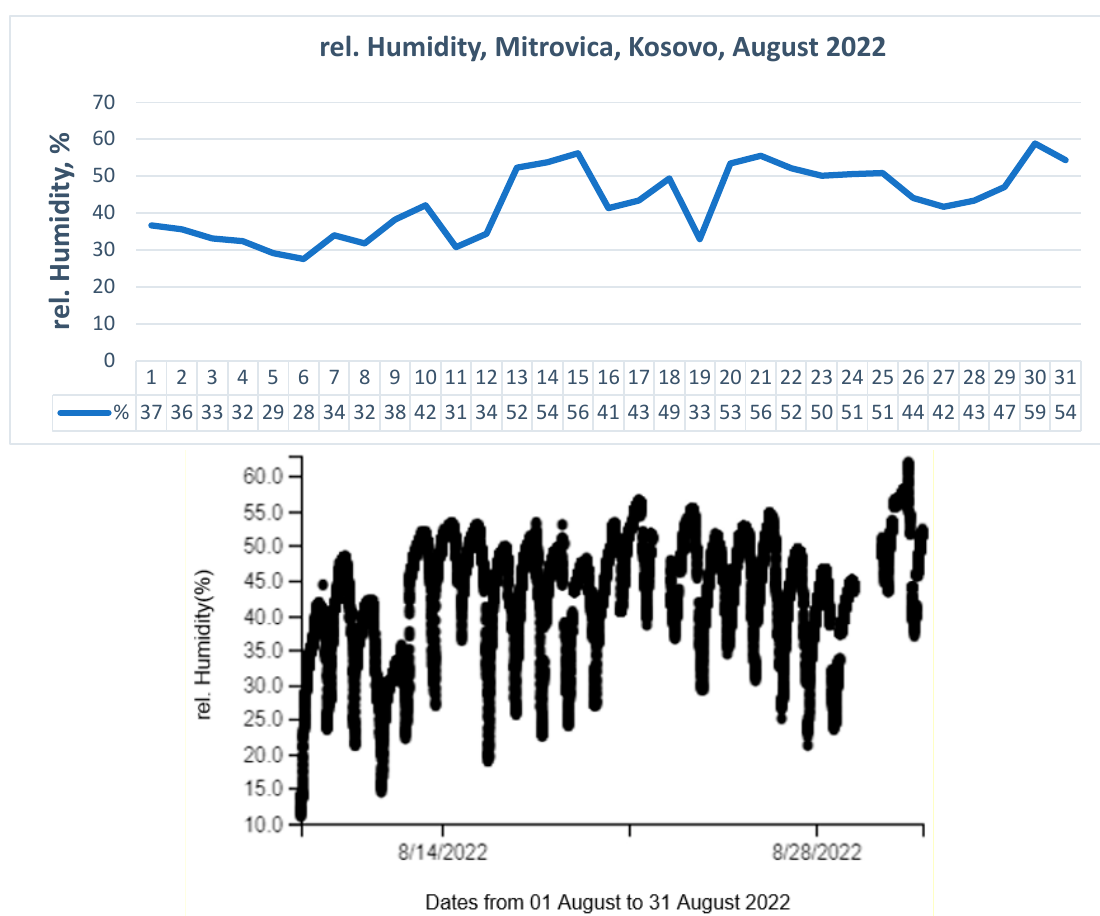
Figure 4. Minimum relative humidity in August 2022.